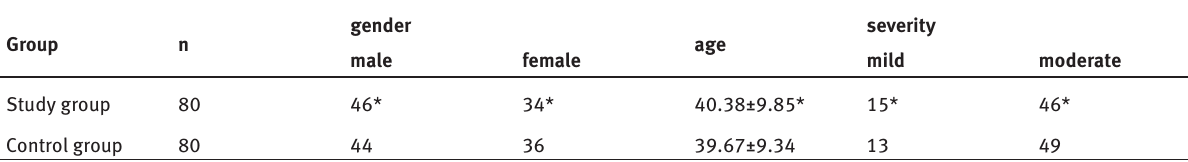
Table 1: General information between two groups.